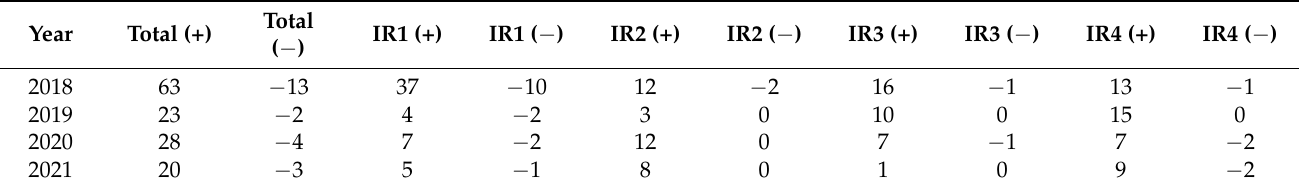
Table A1. Summary table of positive and negative outcomes for intermediate results (IRs) a by year 2018–2021.